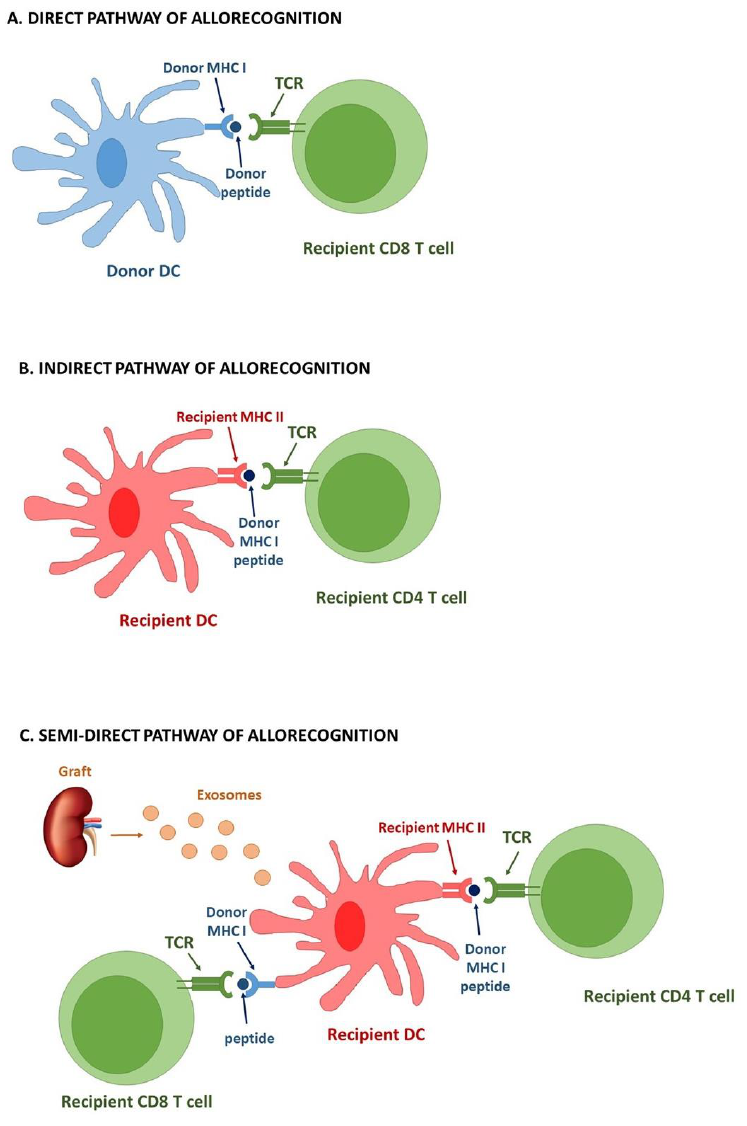
Figure 1. Different types of graft allorecognition mediated by recipient T cells. ( A ). Direct pathway– donor DCs migrate to recipient lymph nodes and present allo-MHC molecules to